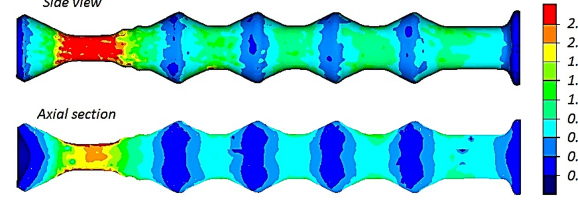
Figure 8: Distribution of the damage function (according to Cockroft-Latham) in the preform produced by skew rolling.